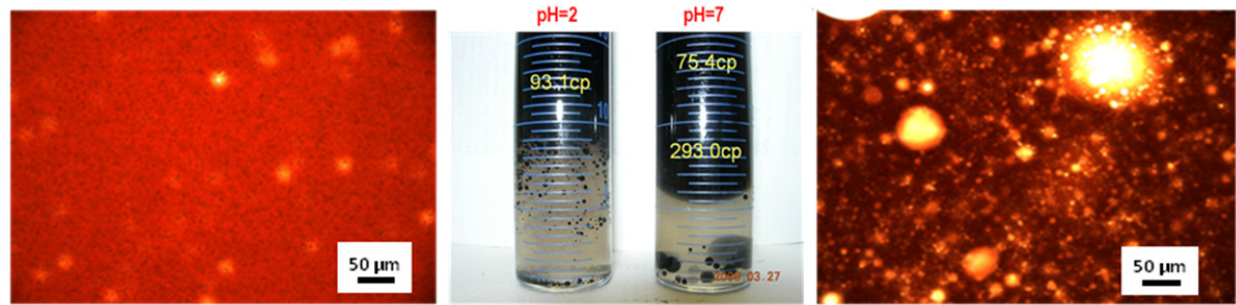
Figure 9. Kaofine stabilized emulsions. On the left, optical micrograph of the W/O emulsion at pH~2. On the right, micrograph of the W/O emulsion at